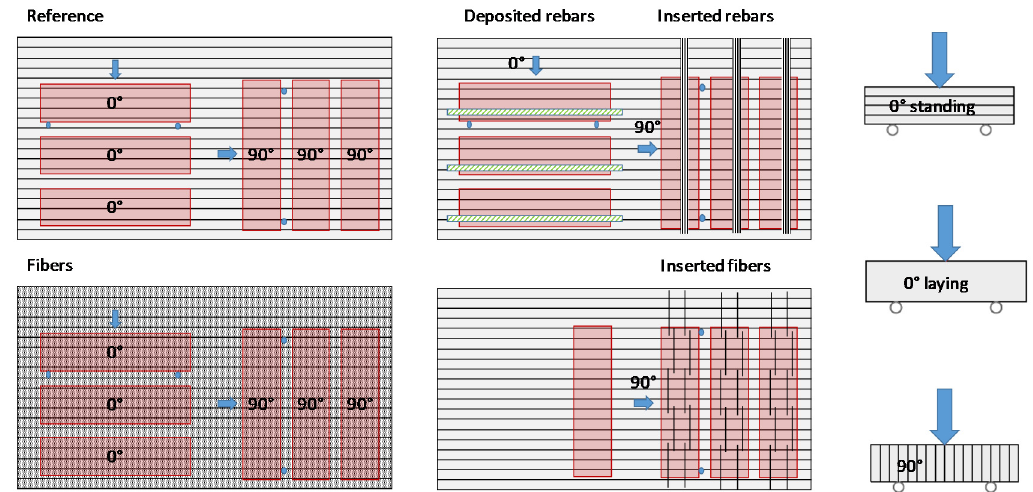
Figure 4. Schema of test prism cut out of 3D-printed element and test directions for flexural strength.